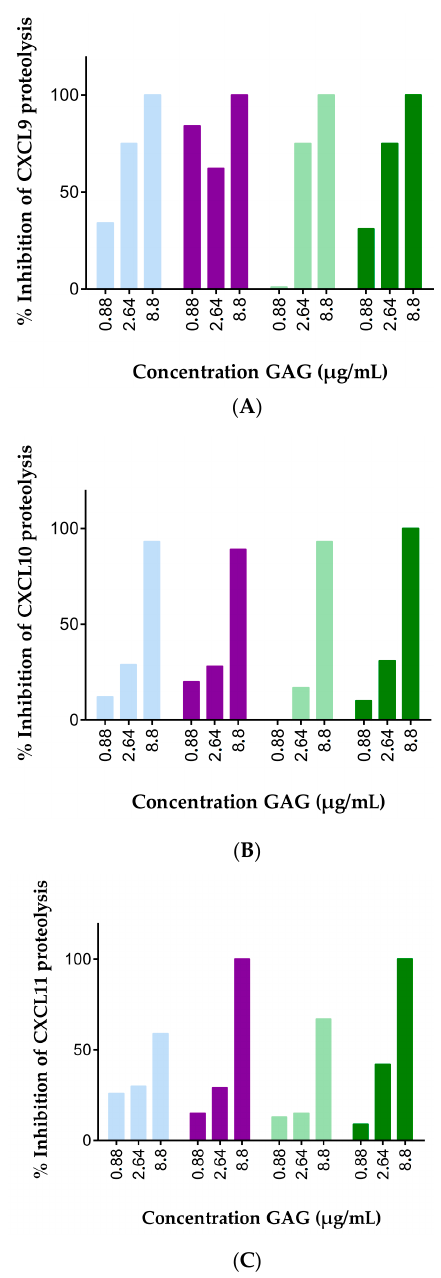
Figure 2. GAGs dose-dependently protect IFN- γ -inducible CXCR3 ligands from cleavage by CD26. Recombinant human: CXCL9 ( A ); CXCL10 ( B ) or CXCL11( C ) (20 µg/mL) was incubated with 12.5 U/L natural human CD26 and 0.88 to 8.8 µg/mL heparan sulfate (violet, ● ), heparin (light blue, ● ), chondroitin sulfate A (light green, ● ) or chondroitin sulfate C (green, ● ) in 50 mM Tris buffer supplemented with 1 mM EDTA (pH 7,5). Reactions were terminated after 2 h by acidification to 0.08% ( v / v ) TFA. The ratio of truncated CXCL9(3–103), CXCL10(3–77) or CXCL11(3–73) over corresponding intact chemokines was determined after C18 purification and mass spectrometry. Results are represented as percentages of GAG-mediated inhibition of proteolysis of CXCL10 by CD26.